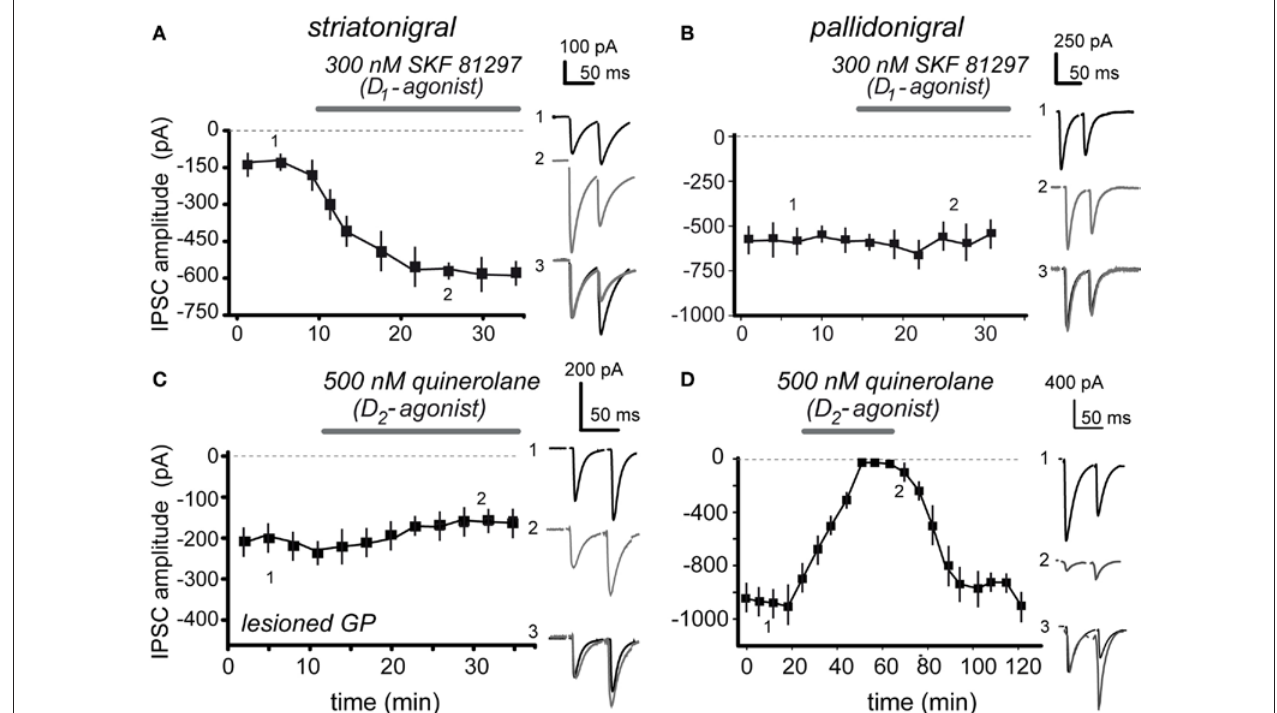
some cases the GPe was lesioned to better avoid contamination from Figure 2 | Contrasting actions of D - and D -receptor agonists on 1 2 pallidonigral afferents. (D) 500 nM quinelorane greatly reduced pallidonigral striatonigral and pallidonigral iPSCs. (A) 100 nM of the selective D -class 1 IPSCs. Note changes in PPR accompanying significant effects. Record 3 in each receptor agonist, SKF 81297, enhanced striatonigral IPSCs. (B) 100 nM SKF frame is the superimposition of records 1 and 2 after normalization of the 81297, had no action on pallidonigral IPSCs. (C) 500 nM of the selective D -class 2 receptor agonist, quinelorane, had no significant action on striatonigral IPSCs. In